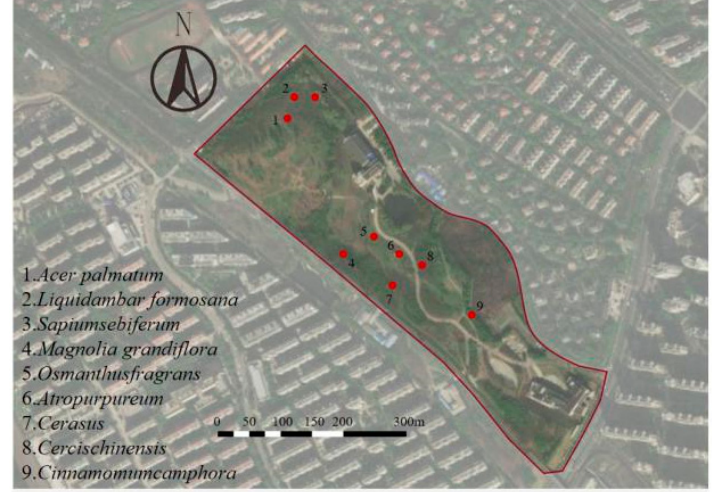
Figure 3. Sample distribution map.